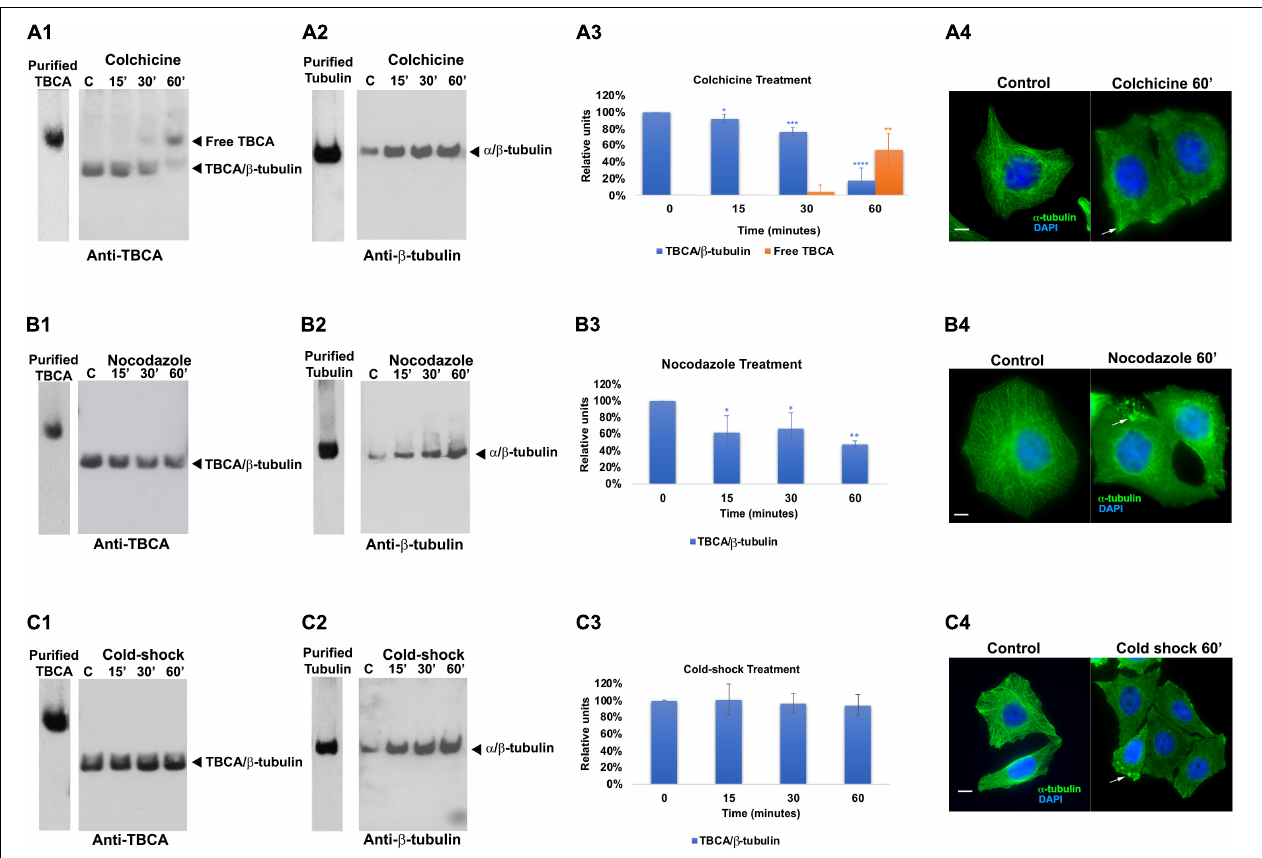
FIGURE 1 | Colchicine treatment triggers the appearance of free TBCA in HeLa cells. HeLa cells were treated with different microtubule depolymerizing agents (colchicine, nocodazole, and cold shock) for 15, 30, and 60 min. After each treatment, native protein extracts were prepared, and equal amounts of soluble protein extracts (30 µ g) were analyzed by non-denaturing gel electrophoresis (6% native-PAGE) followed by western blot with antibodies directed to TBCA (A1,B1,C1) and β -tubulin (A2,B2,C2) . Representative images of the native-PAGE show that: free TBCA was not detected in all-control cells (untreated) (A1,B1,C1) ; upon colchicine treatment, the amount of TBCA/ β -tubulin complex progressively decreases over the indicated time-frames reaching the lowest level at 60 min which is accompanied by the detection of free TBCA in the cell extract ( A1,A3 : * p < 0.05, ** p < 0.01, *** p < 0.005, and **** p < 0.001); under nocodazole treatment TBCA/ β -tubulin complex also decreases at 60 min to exposure of cells to this anti-mitotic drug, but free TBCA is never detected ( B1,B3 : * p < 0.05 and ** p < 0.0001); and under cold shock treatment the levels of the TBCA/ β -tubulin complex are maintained (C1,C3) . The soluble α / β -tubulin levels increase in response to MT depolymerization (A2,B2,C2) . The graphs in panels (A3) (colchicine), (B3) (nocodazole), and (C3) (cold-shock), show the relative units in percentage of TBCA/ β -tubulin complex and free TBCA levels in comparison to control cells (100%). Statistical significance was calculated using a t -test and the p -values were determined in comparison to the time 0 min (control). The graphic bars are the mean s.d. (error bars) of three independent assays. For each treatment, the MT depolymerization was confirmed by indirect immunofluorescence using an antibody against α -tubulin (A4,B4,C4) (the DNA was stained with DAPI, scale bar 10 µ